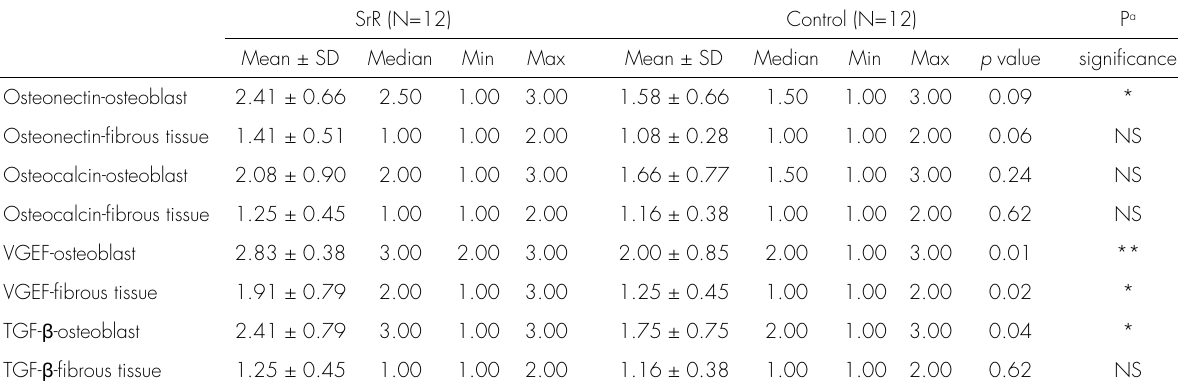
Table IV. Result of immunohistochemical